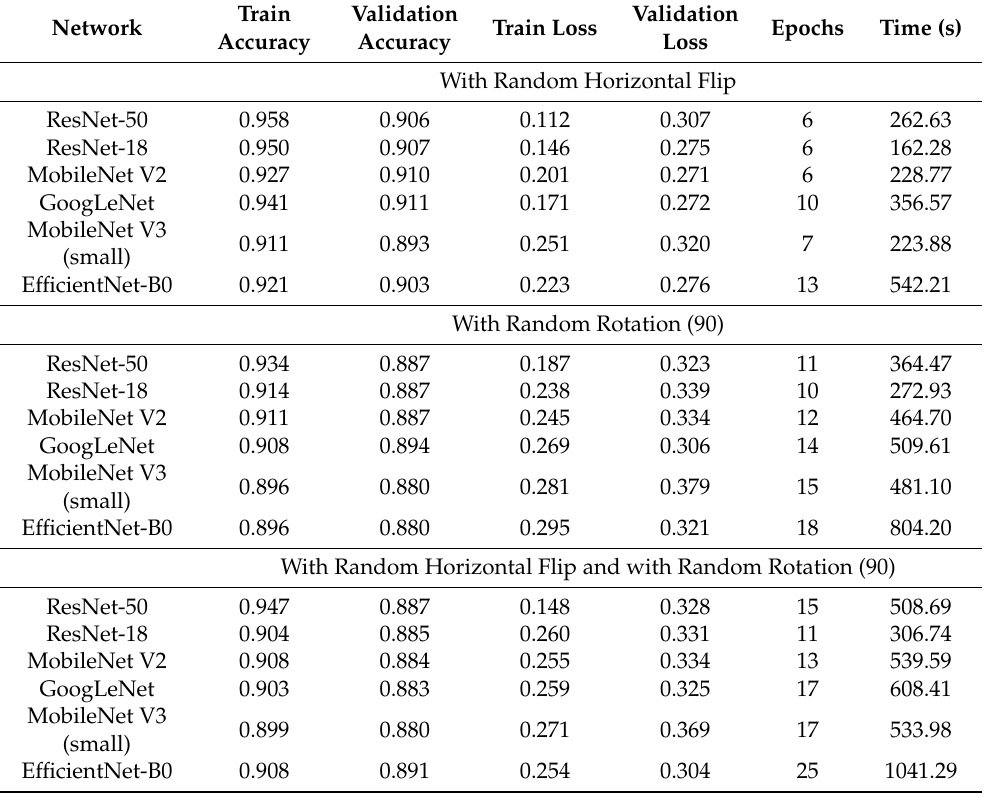
Table 7. Test performance results with augmented